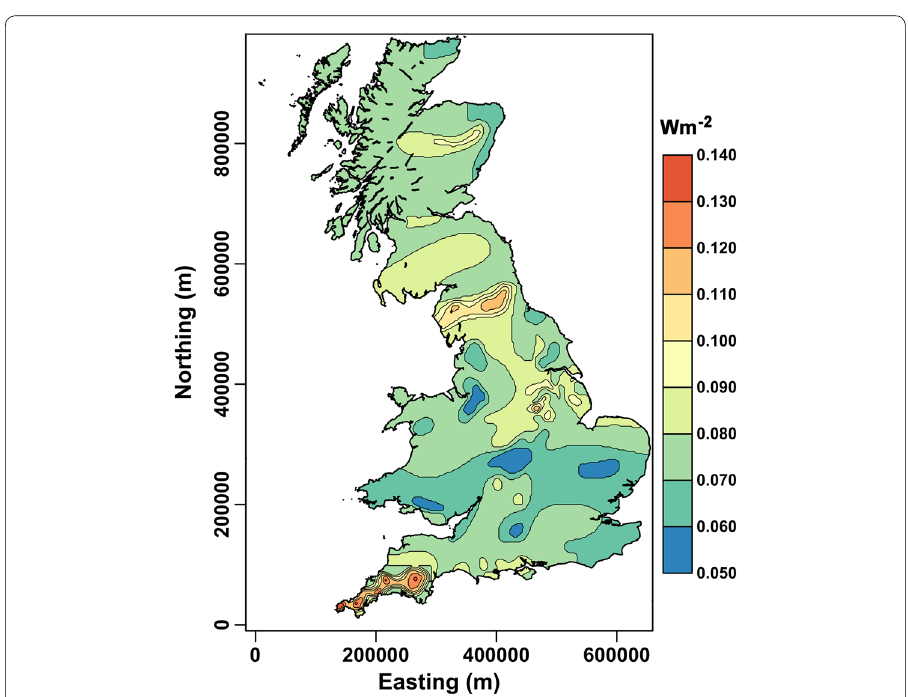
Fig. 4 Surface heat flow map for Great Britain that includes a first pass correction for the effects of palaeocli- mate